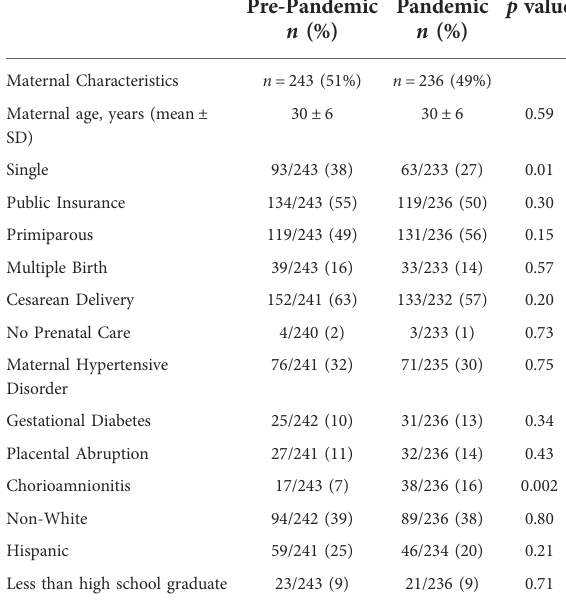
TABLE 1 Maternal characteristics and medical